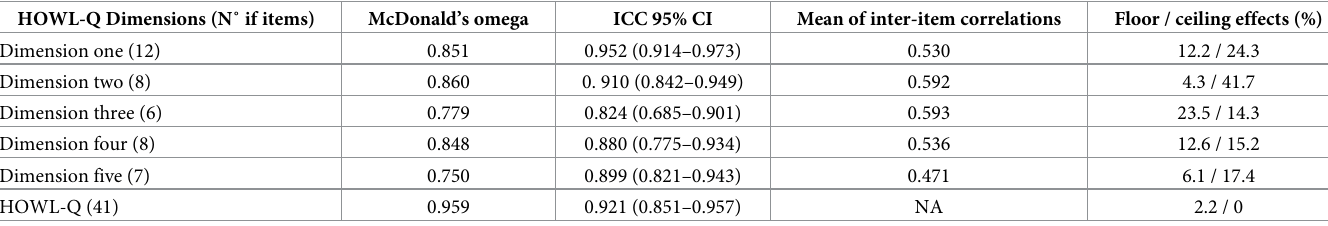
Table 7. Psychometric characteristics dimensions that integrated the final version of